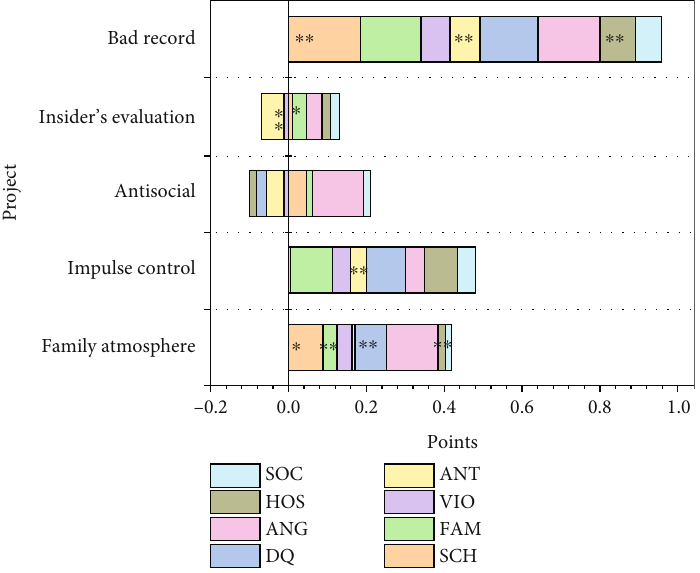
Figure 7: Results of correlation analysis of the scale and the